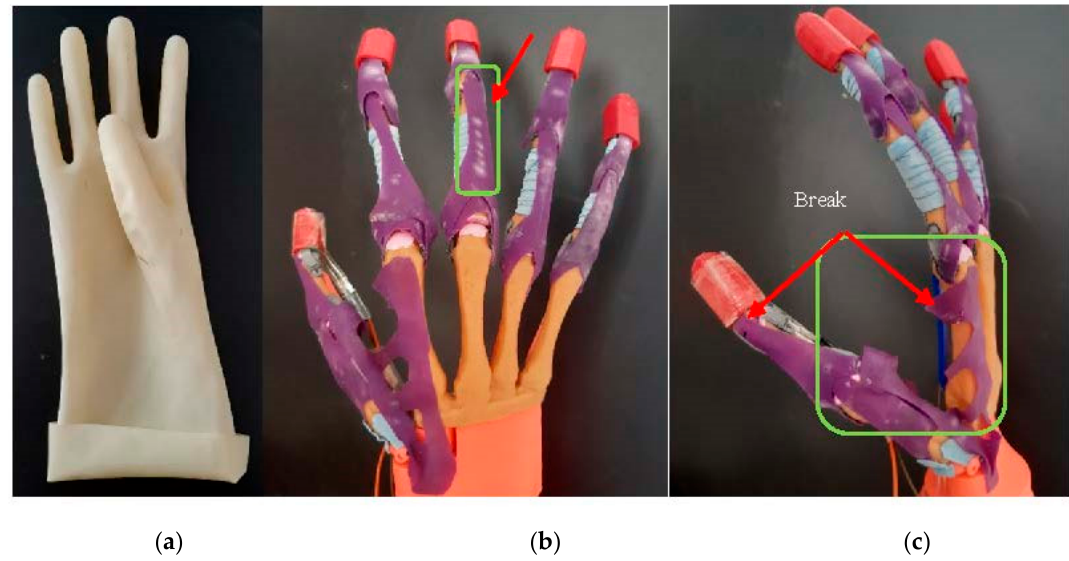
Figure 10. Rubber materials defects after 6 months of using. ( a ) The rubber glove form prevents the correct abduction of the thumb. The 90 degrees of the thumb placement does not allow the prosthetic hand to correctly manipulate the objects. ( b ) Extensor tendon wear due to friction with the tendon sheath. ( c ) Artificial Adductor policis (muscle) fracture.